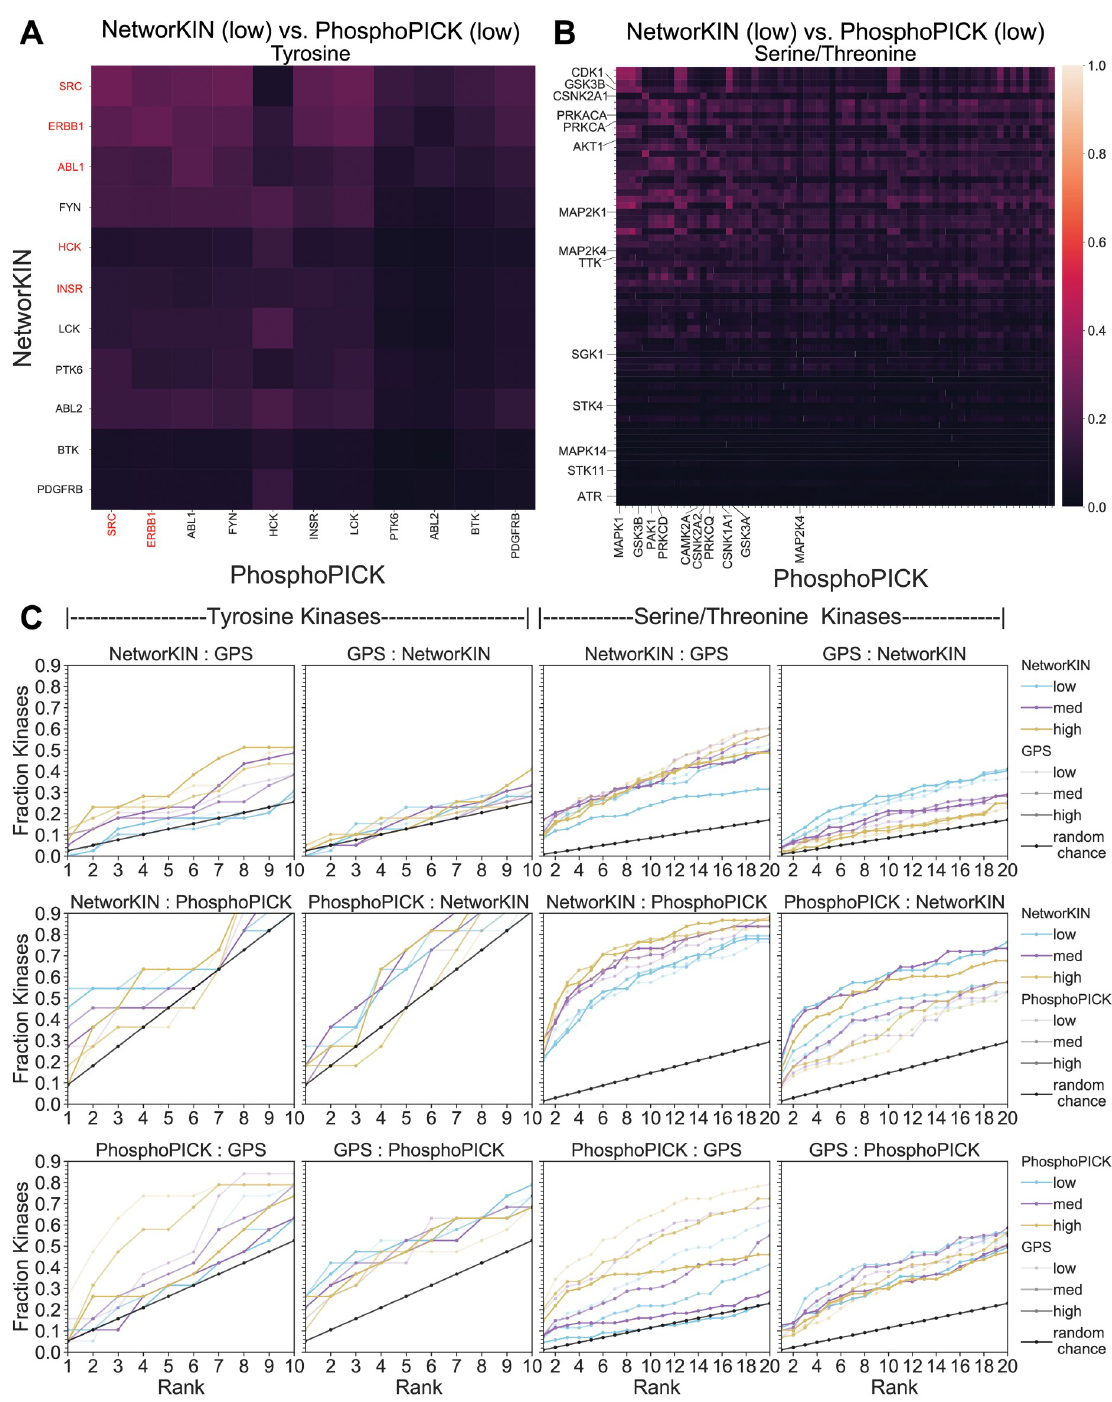
Fig 5. Between-algorithm kinase similarity. A: Jaccard index matrix (non-symmetric), comparing GPS and NetworKIN tyrosine kinases at low stringency, where highlighted labels in red fall within the top 1% of all kinase comparisons B: Jaccard index matrices (non- symmetric), comparing GPS and NetworKIN serine/threonine kinases at low threshold, where labels indicate that comparison falls within the top 1% of all kinase comparisons. C: In order to understand if the highest overlap of a kinase in one algorithm is the same kinase in the other algorithm, we calculated the cumulative distributions of the fraction of this match from the highest ranked kinase to the top 10 (tyrosine kinases) or top 20 (serine/threonine kinases). For example, a y-axis value of 0.3 at x-axis value of 2 means that 30% of the kinase comparisons from algorithm A to algorithm B, where the title defines A:B comparison in that panel, have a JI value that puts them in the top 2 of all kinase-kinase comparisons. The black line gives an estimation of what is expected by random chance. This calculation was run